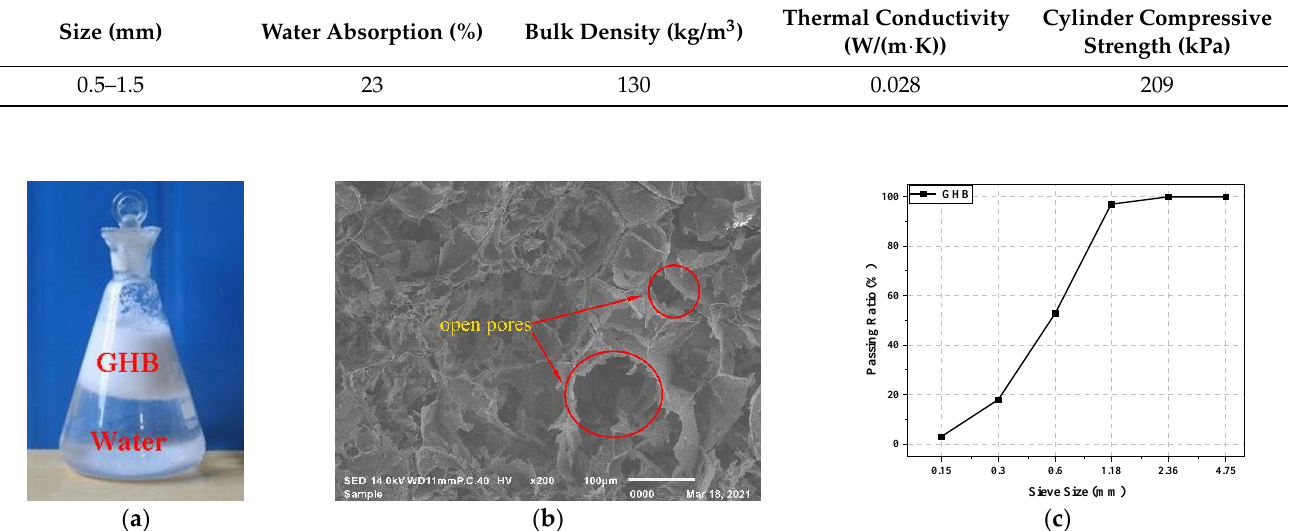
Figure 1. ( a ) The GHBs after soaking in water for three months and ( b ) SEM image of GHB and ( c ) Sieve size distribution of GHB.